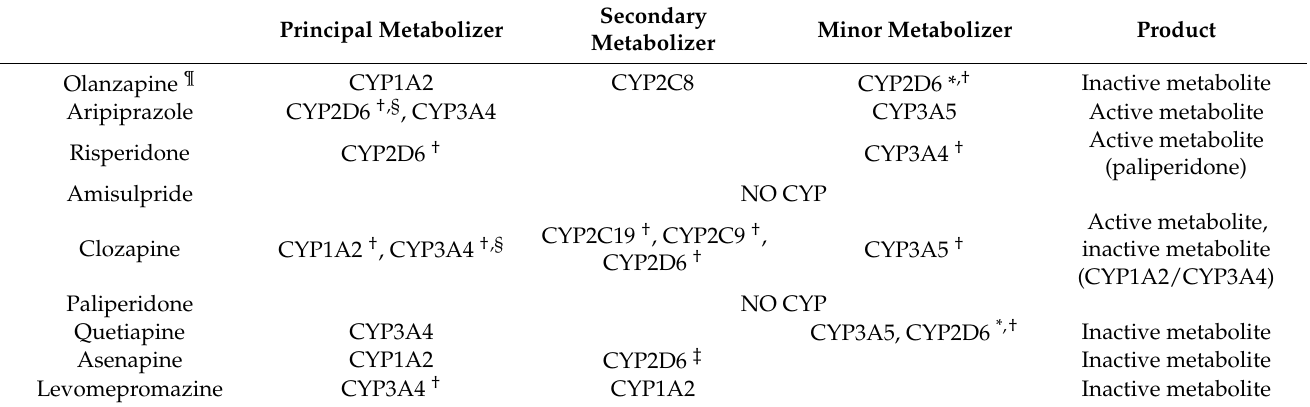
Table 1. Antipsychotic metabolism